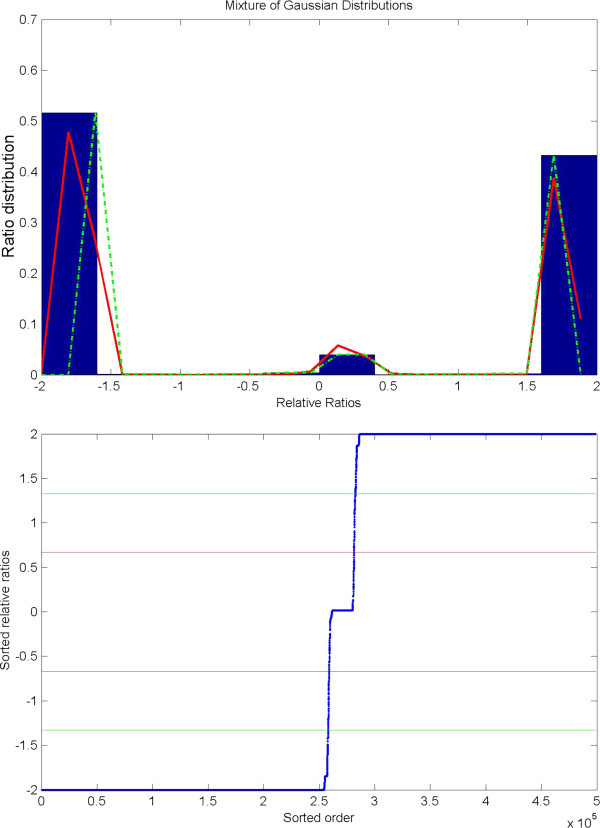
Distribution of relative ratios of chromosome interaction changes. Upper panel: Histogram of relative ratios (chromosomal interaction changes in 1 Mb resolution, E2-treated vs control condition). Lower panel: sorted relative ratios, red smooth line is relative ratio equals 0.67 (e.g., a 2 fold change) and green smooth line is relative ratio equals 1.33 (e.g., a 5 fold change). Non-interaction elements are excluded from analysis such as Z-score equals 0 in both control and E2-treated interaction matrices. A 10-fold interaction change is expected when the relative ratio equals 1.63, gain and lost interactions are equivalent to the relative ratio 2 and −2, respectively.